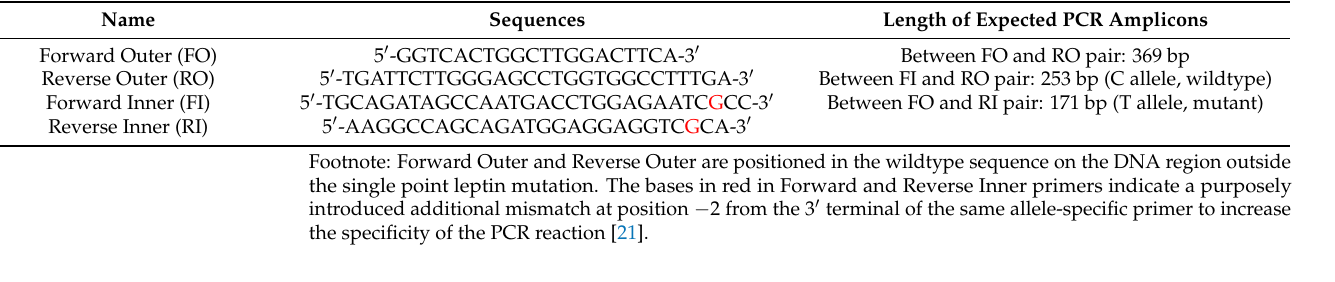
Table 1. Tetra-primer ARMS-PCR primers for the detection of obese gene point